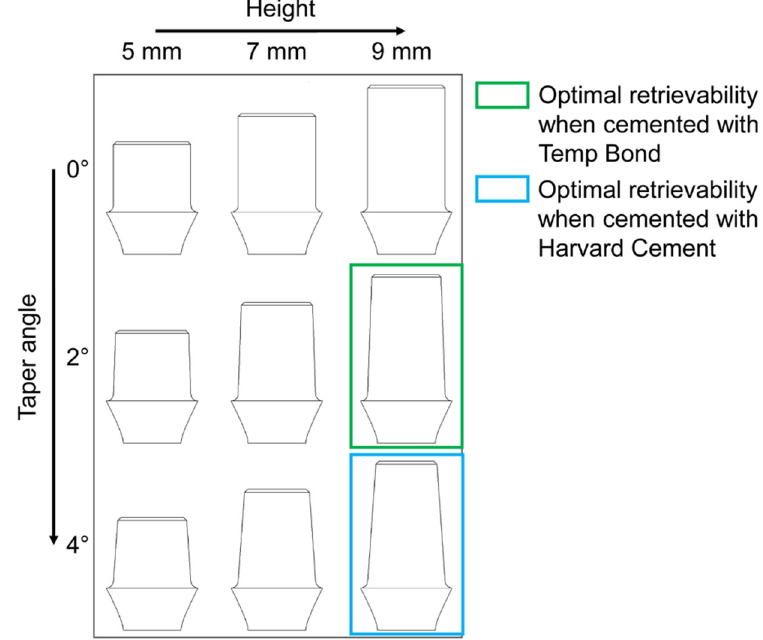
Figure 10. Optimal height–taper angle combinations resulted from the present study: the best percentages of good retrievability were obtained with Harvard-cemented copings on 9 mm and 4° abutments and with Temp Bond-cemented ones on 9 mm and 2° abutments.